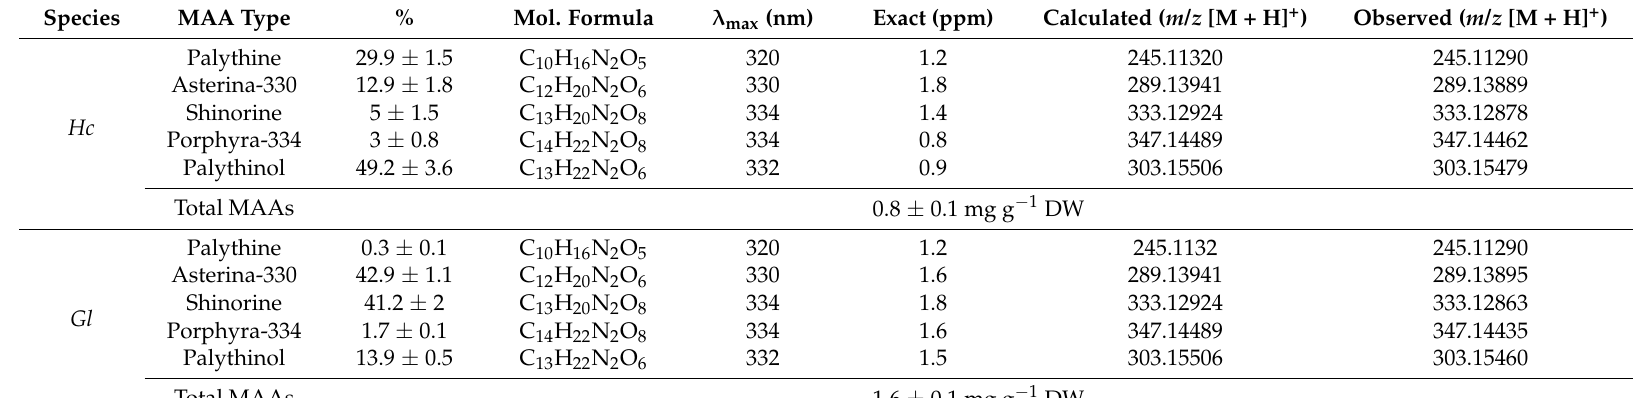
Table 1. UV-sunscreen mycosporine-like amino acids (MAAs) isolated from Hydropuntia cornea ( Hc ) and Gracilariopsis longissima ( Gl